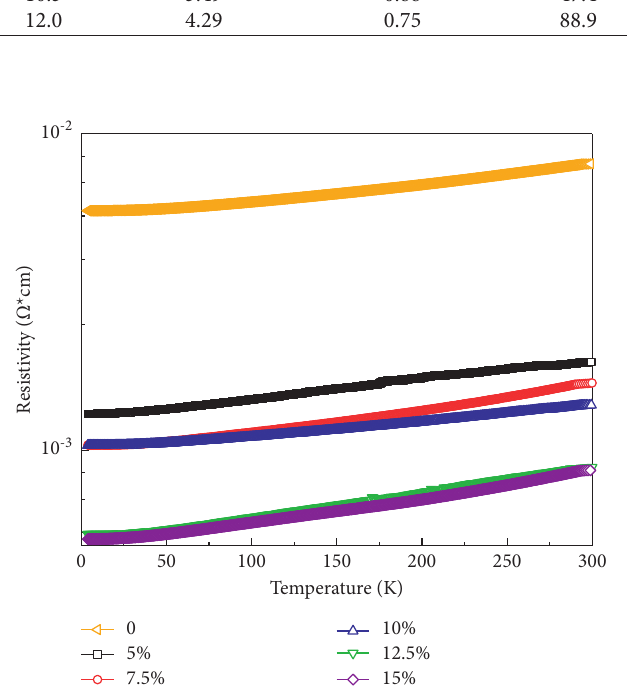
Figure 5: The temperature dependence of resistivity for ( Sr